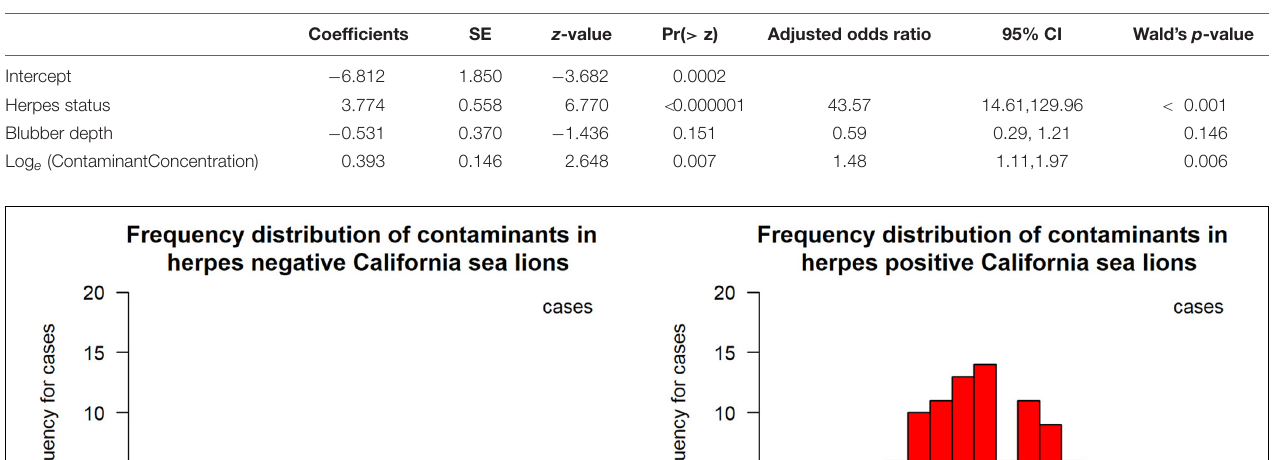
TABLE 3 | Logistic regression model investigating probability of cancer in relation to herpesvirus status and blubber contaminant concentrations (log e [sum contaminant concentrations, ng g − 1 lipid weight]) after controlling for blubber depth (glm[CaseControl ∼ HerpesStatus] + BlubberDepth + Log e [ContaminantConcentration], n = 252).